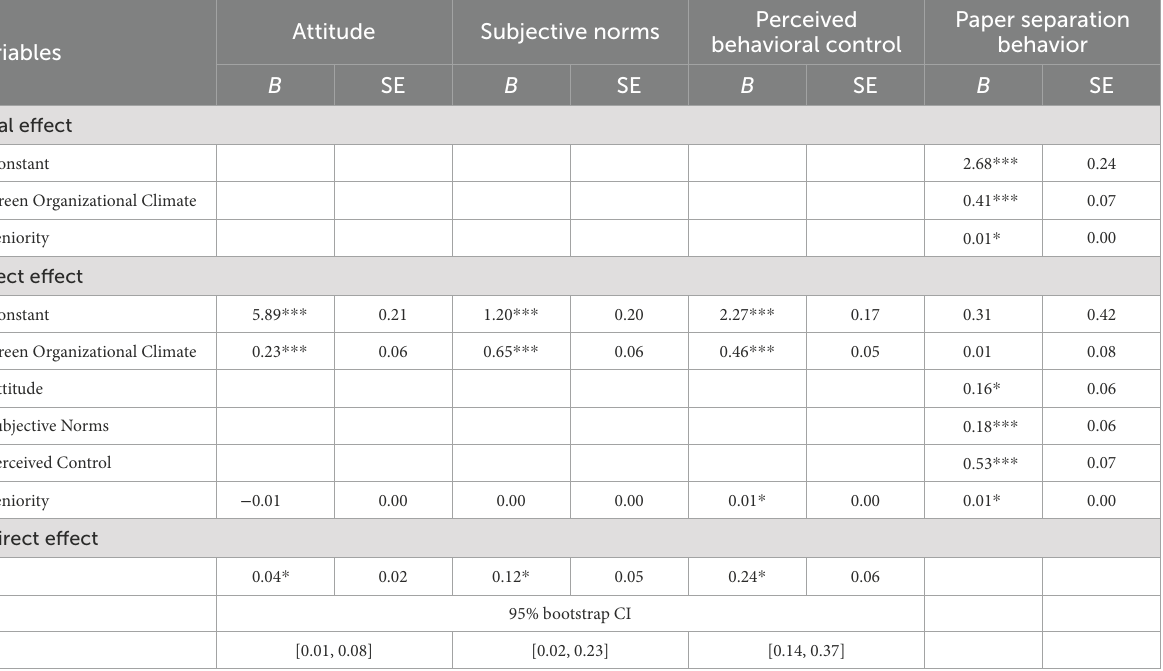
TABLE 3 Total, direct, and indirect effects for paper separation.